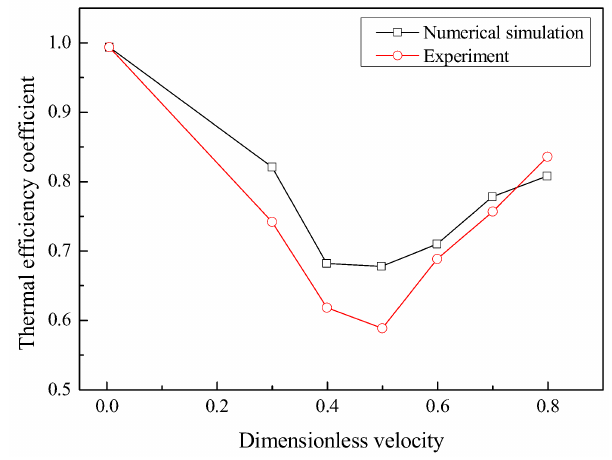
Figure 10. Comparison of thermal efficiency coefficients from numerical simulation with those from the